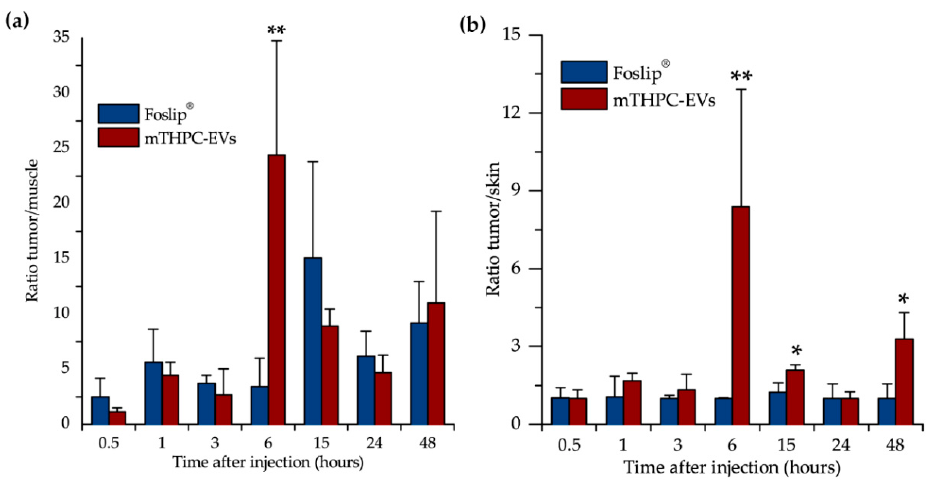
Figure 4. ( a ) Tumor/muscle and ( b ) tumor/skin ratio after Foslip ® and mTHPC-EV injection. * p < 0.05; ** p < 0.01.